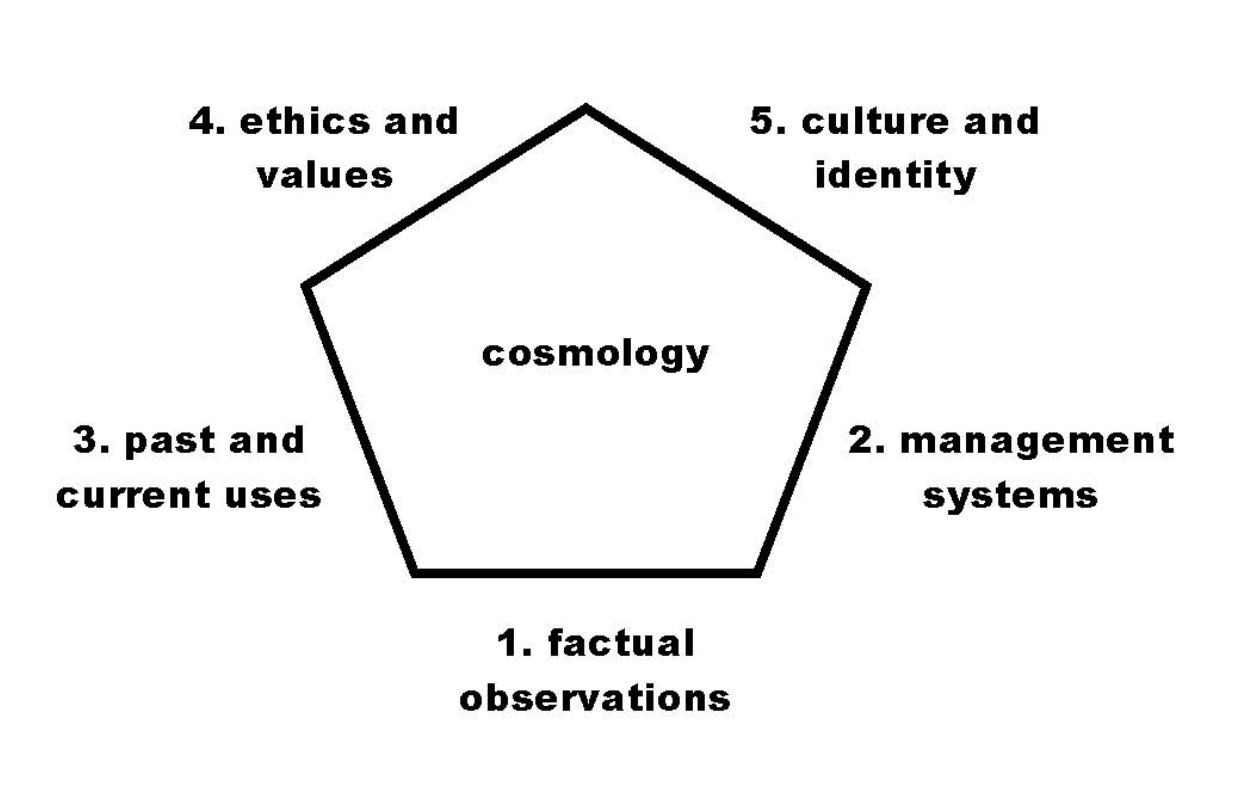
Fig. 1. The six faces of traditional ecological